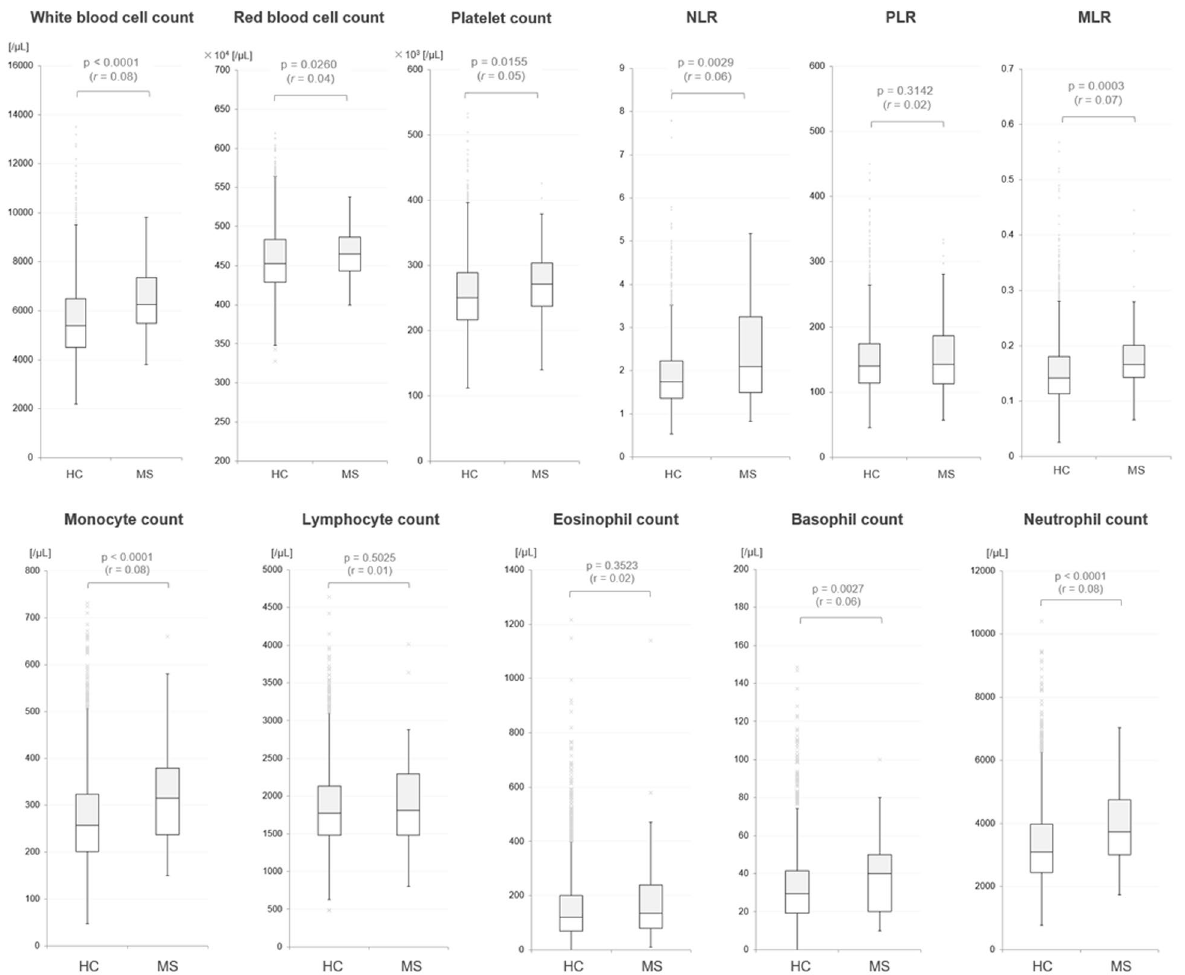
Figure 1. Boxplots of blood cell subtypes in the HC and MS Groups. Boxplots for three blood cell types, five differential white blood cell subtypes, and the three derived ratios (NLR, PLR, MLR) calculated from the differential white blood cell counts are shown. The p-values are the results of the Mann–Whitney U test, and the effect size r below each p-value was calculated as (cid:31) Z / √ n (cid:30) . HC, healthy controls; MLR, monocyte-to-lymphocyte ratio; MS, multiple sclerosis; NLR, neutrophil-to-lymphocyte ratio; PLR, platelet-to-lymphocyte